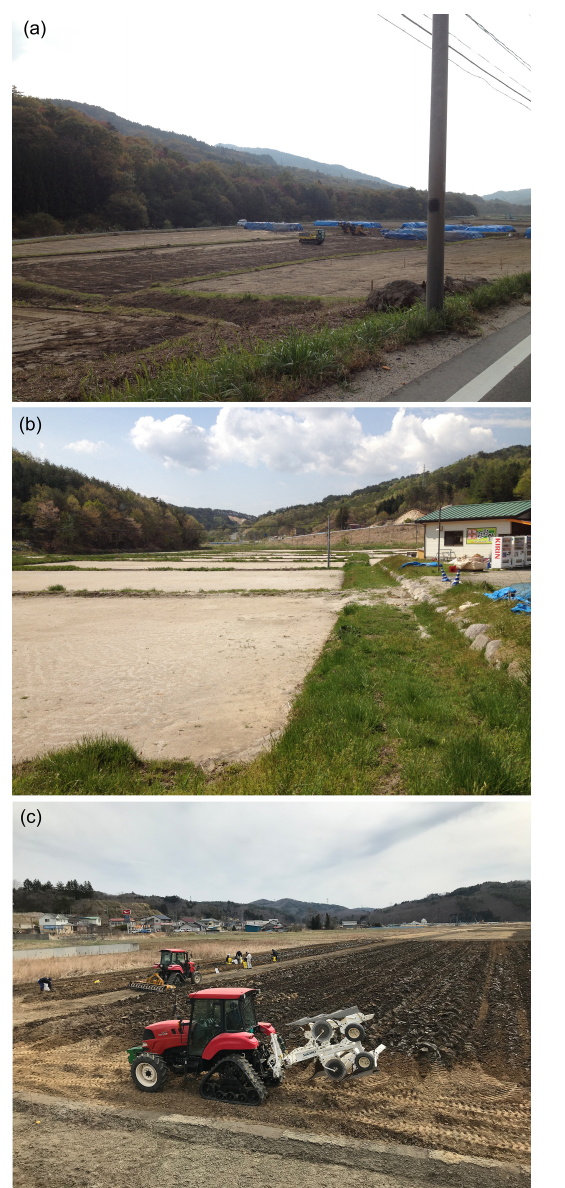
Figure 3. Illustration of the different steps of remediation activ- ities in cultivated land in Fukushima: (a) removal of the 5cm topsoil layer concentrating most of the radiocesium (November 2013); (b) addition of a crushed granite layer on top of the resid- ual soil profile (May 2014); (c) final mixing of the entire profile to prepare re-cultivation (March 2019). Pictures were taken by the authors in the Iitate